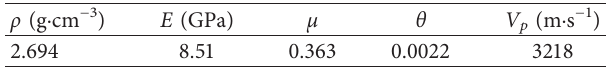
ρ , density; E , elastic modulus; μ , Poisson’s ratio of the rock; θ , failure strain; V p , velocity of the longitudinal waves of the